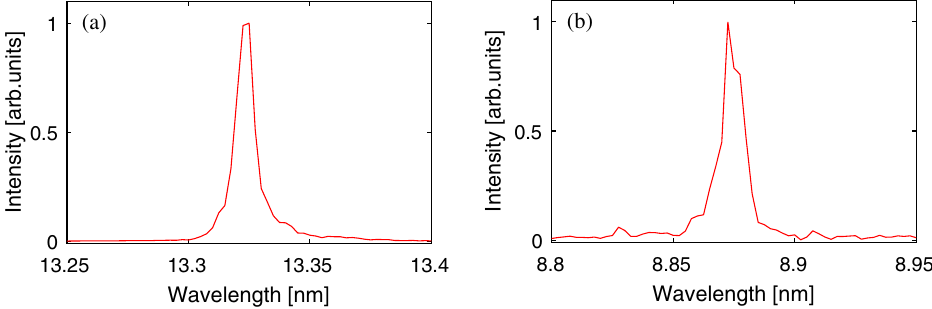
FIG. 5. Output spectra of EEHG at 20th and 30th harmonics of the seed laser (accumulated with integration over 50